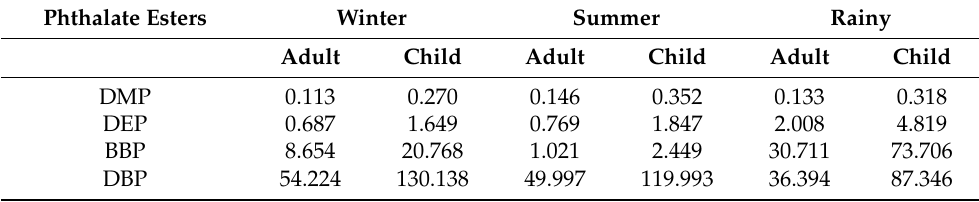
Table 3. Human health risk assessment of phthalates in water samples of Harike wetland. Phthalate Esters